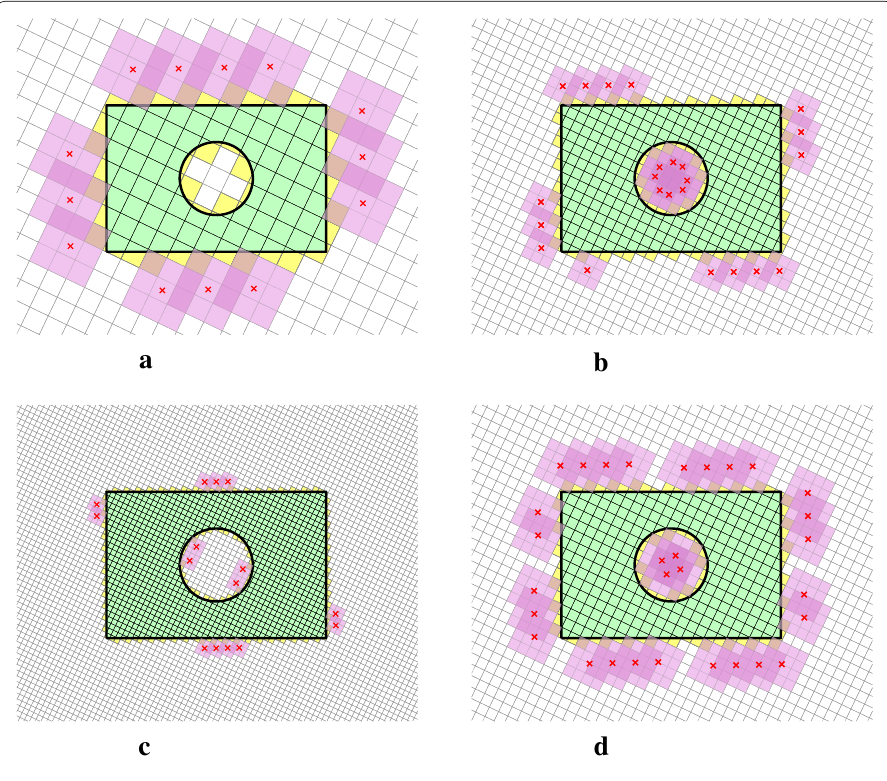
Fig. 6 Four realizations of removed basis functions using on the stiffness matrix based selection procedure described in “Interpolation error estimates” section; all using the same constant c = 0 . 01 for the tolerance √ E in (51). Each cross marks a removed basis function and the domain of its support is visualized tol = ch p × in pink. In ( a )–( c ) we note that the selection becomes more restrictive with smaller mesh size h . Comparing ( b ) and ( d ) we also note that more basis functions typically may be removed as the spline order increases. a C 1 Q 2 , h = 0 . 4. b C 1 Q 2 , h = 0 . 2. c C 1 Q 2 , h = 0 . 1. d C 2 Q 3 , h = 0 . 2